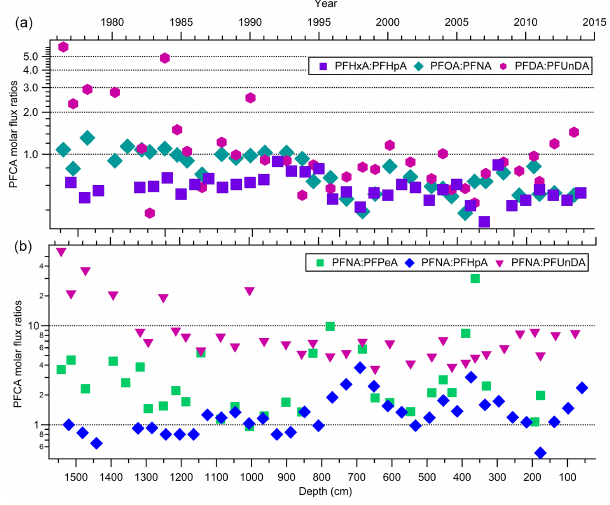
Figure 4. Molar flux ratios for (a) three even–odd pairs of PF- CAs and (b) three odd pairs of PFNA with PFPeA, PFHpA, and PFUnDA homologues, as a function of depth and year.